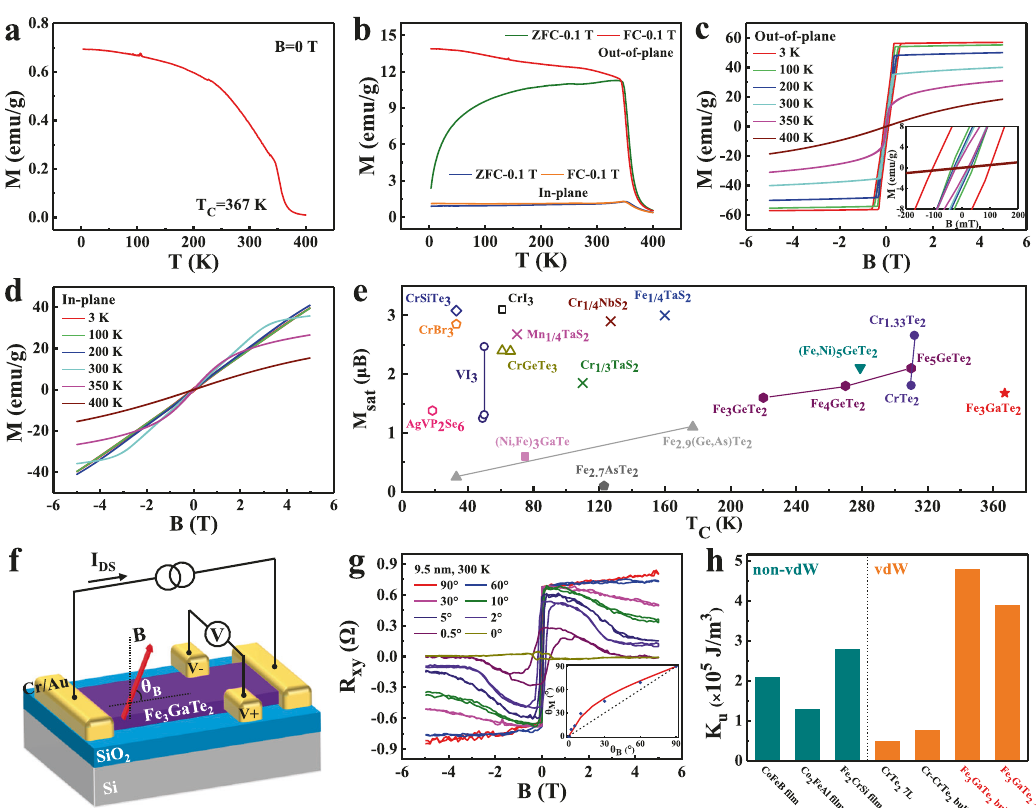
Fig. 2 | Magnetization measurements of bulk Fe 3 GaTe 2 and angle-dependent anomalous Hall effect in few-layer Fe 3 GaTe 2 . Temperature-dependent sponta- neousmagnetization( B =0)( a )andZFC-FC( B =0.1T,out-of-planeandin-plane)( b ) curves of Fe 3 GaTe 2 bulk crystals. M-H curves of Fe 3 GaTe 2 bulk crystals at varying temperatures with magnetic fi elds along the out-of-plane ( c ) and in-plane ( d ) direction. Inset in c shows the enlarged image of hysteresis loops. e T C and M sat comparison for various vdW-type ferromagnets, including vdW ferromagnetic insulators (open symbols), vdW ferromagnetic metals (solid symbols), and the ferromagnetic TMDC compounds (crosses) with intercalation of magnetic